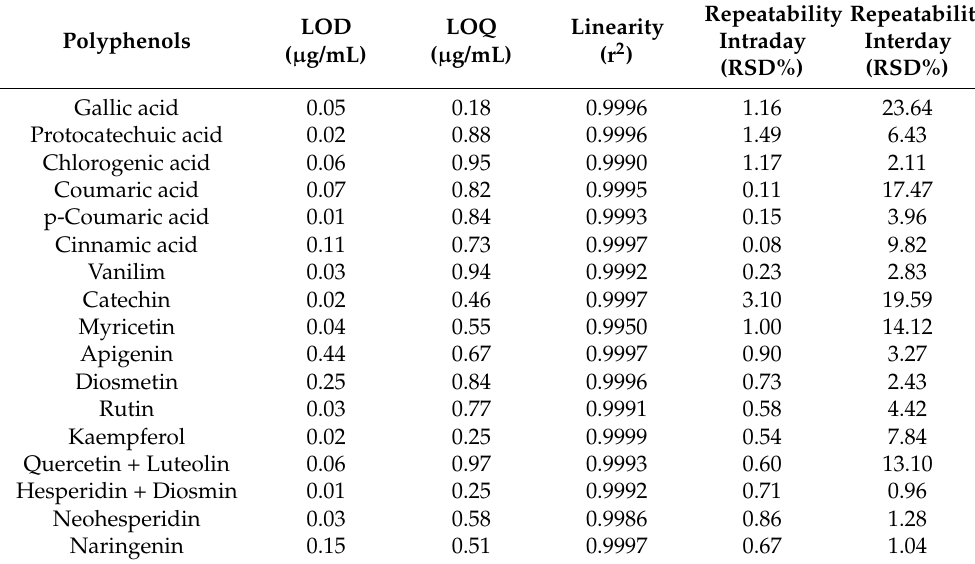
Table A1. Data from the instrumental validation of the chromatographic method developed for the quantification of polyphenols in habanero pepper by-products.